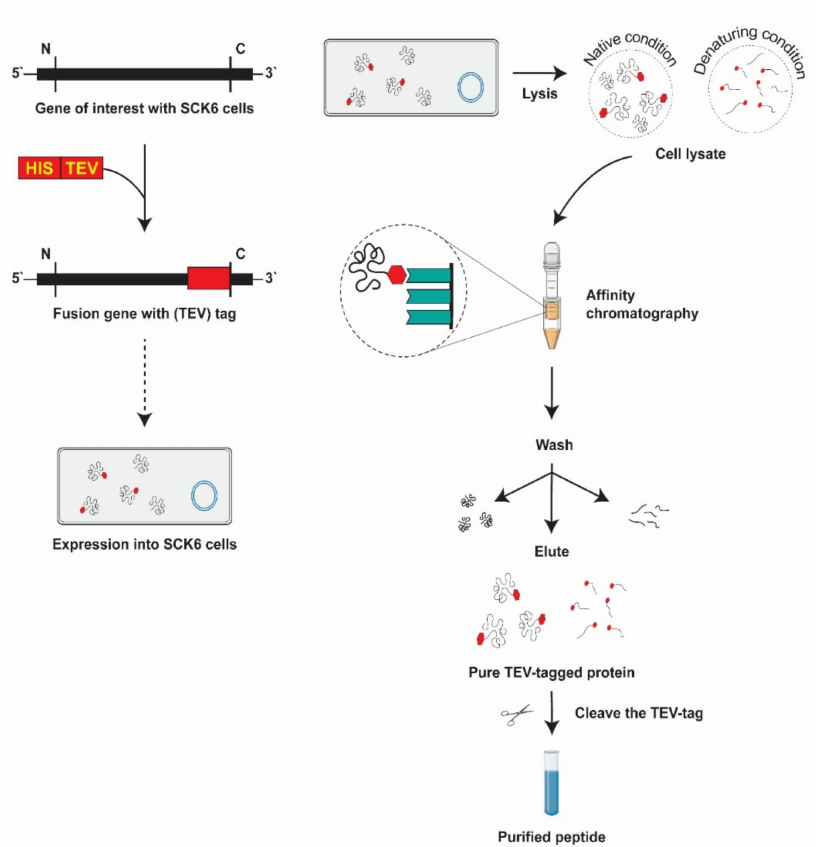
Figure 2. Scheme of procedures used in the purification of antimicrobial peptides by 6xHis tag purification method. A specific tag is initially fused to the target peptide at the DNA level to express tagged fusion protein so that the peptide solution is retrieved and added to a column containing specific relevant protein ligands. Washed undesirable compounds and finally, a TEV-protease to cleave the target peptide from the affinity